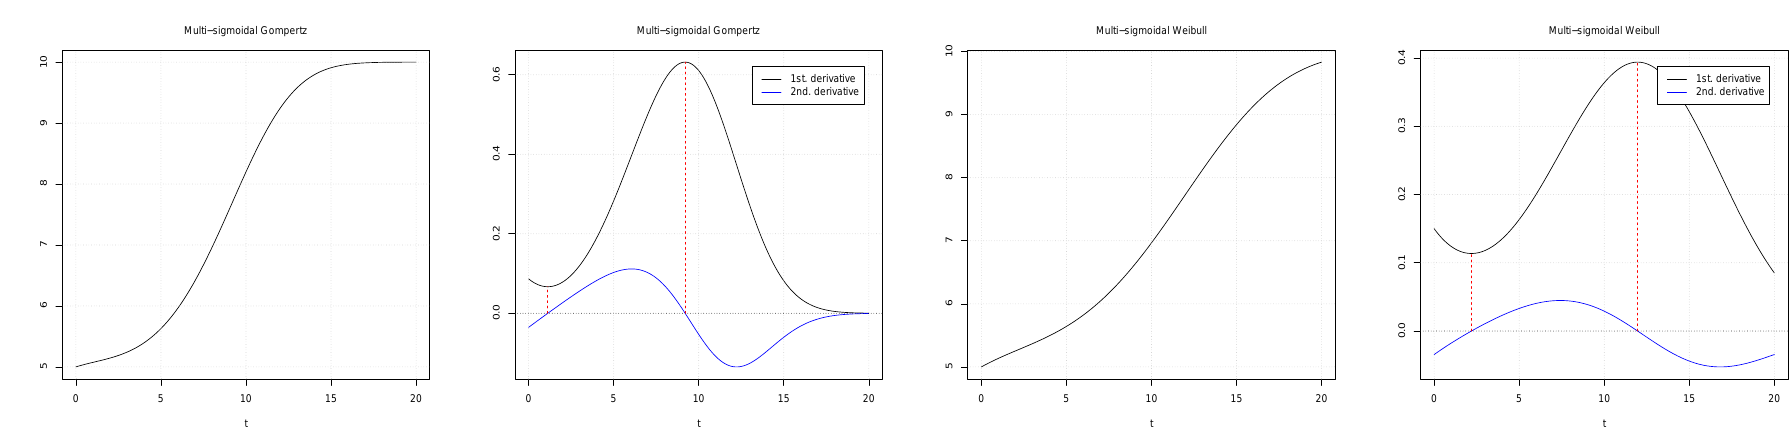
Figure 1. Examples of multi-sigmoidal curves and their inflections. Next to every curve, its first and second derivatives are shown. The first two columns correspond to the multi-sigmoidal Gompertz model, and the others to the multi-sigmoidal Weibull. The rows show, from top to bottom, the cases with no inflection, one and two inflections, respectively, (marked with a red vertical dashed line in the plot of the